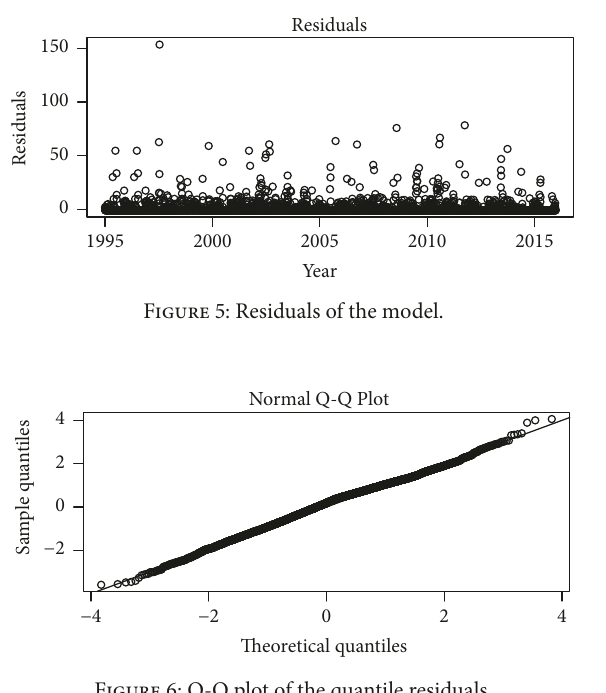
Figure 6: Q-Q plot of the quantile residuals.